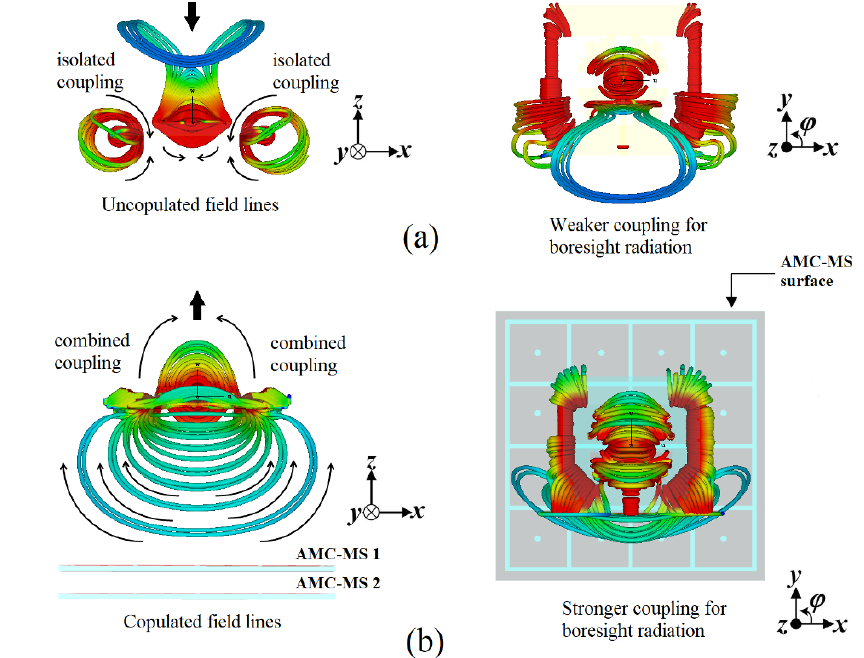
Figure 13. Surface current distributions of proposed antenna configuration: ( a ) without AMC-MS reflector and ( b ) with AMC-MS